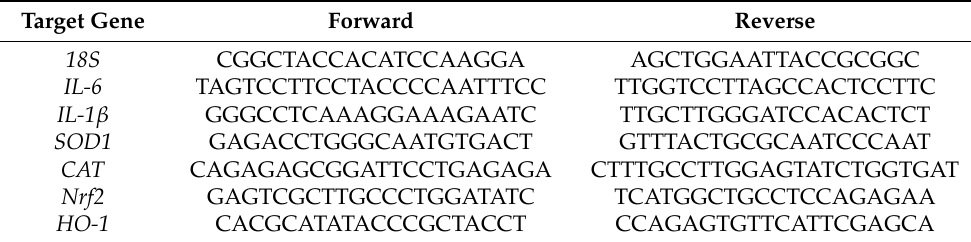
Table 1. Sequences of primer pairs used in sequences of primer pairs used in reverse transcription polymerase chain